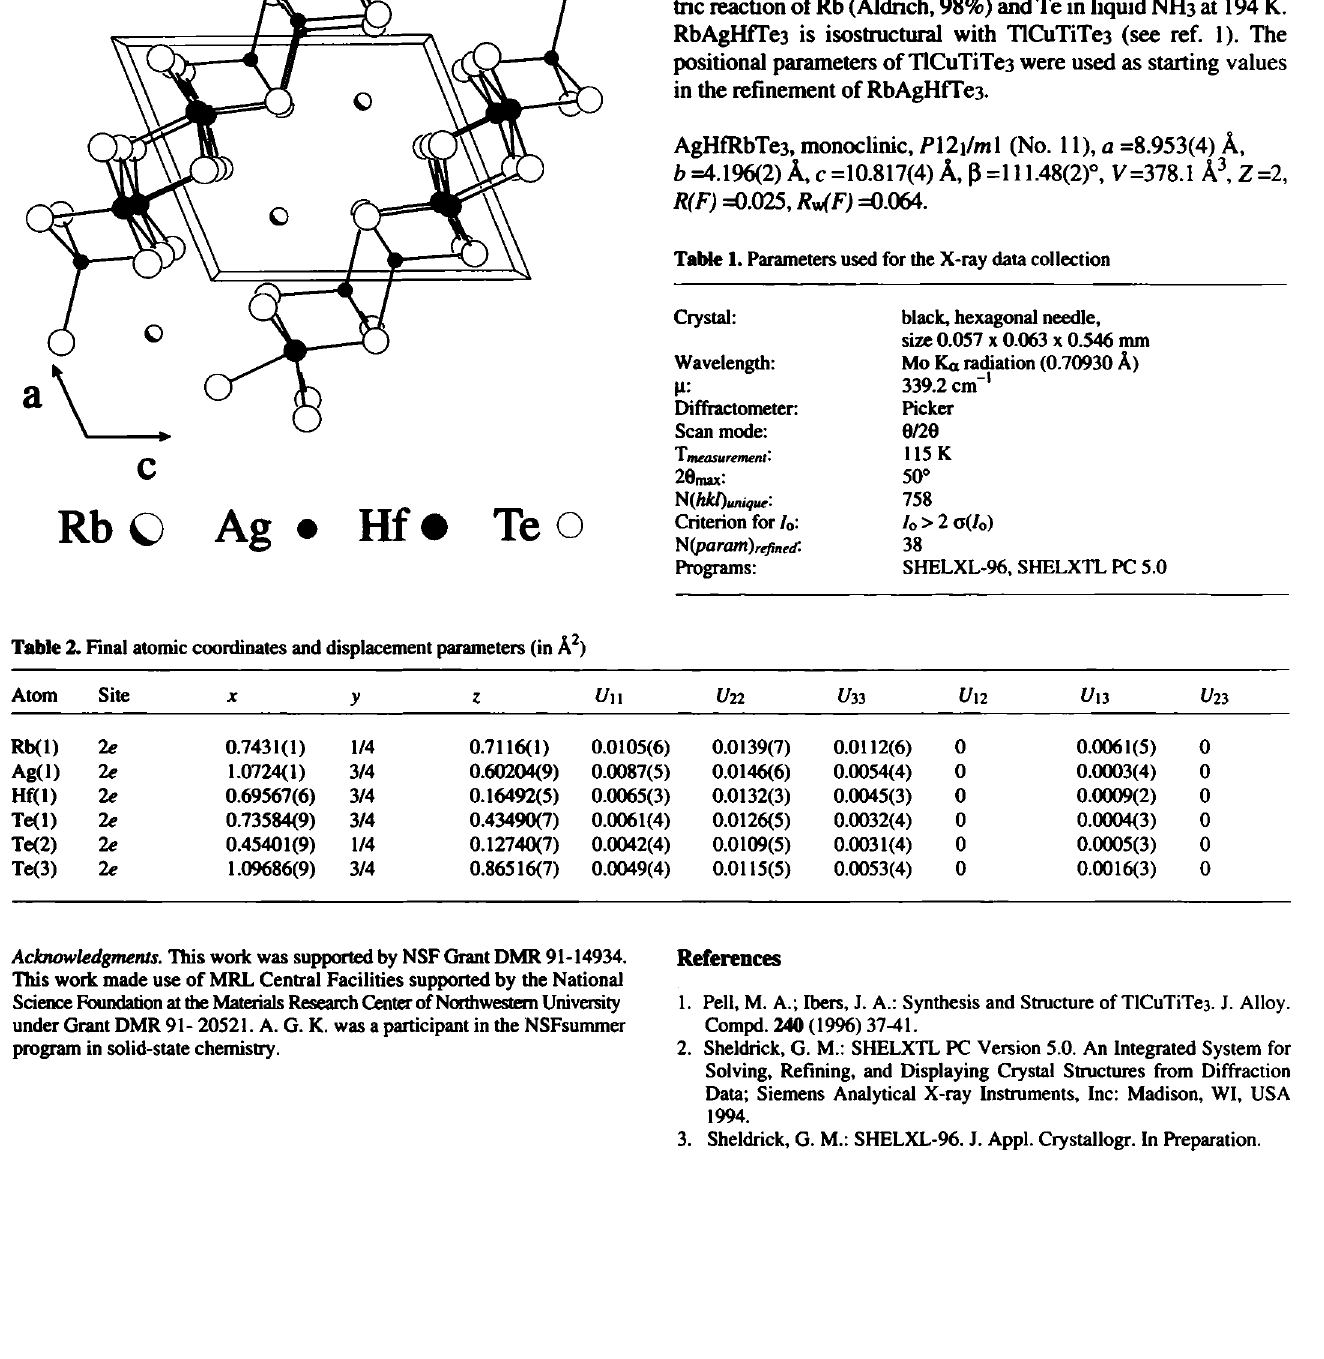
Source of material: Crystals were obtained from a reaction of Rb2Te3, Ag (Johnson Matthey, 99.95%), Hf (Johnson Matthey, 99.6%), and Te (Aldrich, 99.8%) in a 1 : 2 :2 :4 ratio in a fiised- silica tube at 1173 K. Rb2Te3 was synthesized from a stoichiome- tric reaction of Rb (Aldrich, 98%) and Te in liquid NH3 at 194 K. RbAgHfTe3 is isostructural with TlCuTiTe3 (see réf. 1). The positional parameters of TlCuTiTe3 were used as starting values in the refinement of RbAgHfTe3. AgHfRbTe3, monoclinic, P\2\lm\ R(F) =0.025, RvJF) =0.064. Table 1. Parameters used for the X-ray data collection